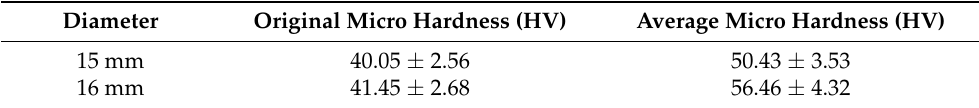
Table 3. The micro hardness of the surface rods before and after cavitation